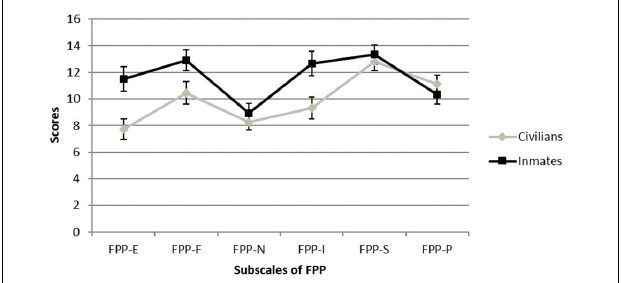
FIGURE 1 | Means and standard errors of FPP subscales for inmates and civilians. FPP-E = Lack of Empathy; FPP-F = Fearlessness; FPP-N = Narcissistic Egocentrism; FPP-I = Impulsivity; FPP-S = Social Manipulation; FPP-P = Power. N = 305.